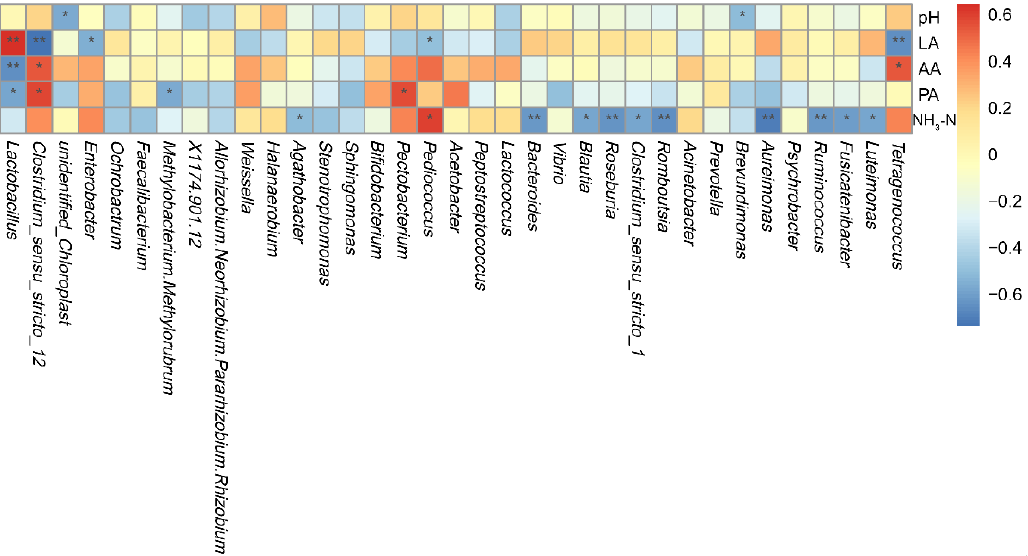
Figure 6. Heat map displaying the correlations between the fermentation quality of Chamaecrista rotundifolia silage and the relative abundance of bacterial genera. pH, hydrogen ion concentration; LA, lactic acid; AA, acetic acid; PA, propionic acid; NH 3 -N, ammonia nitrogen as a percentage of total nitrogen. * p < 0.05; ** p <